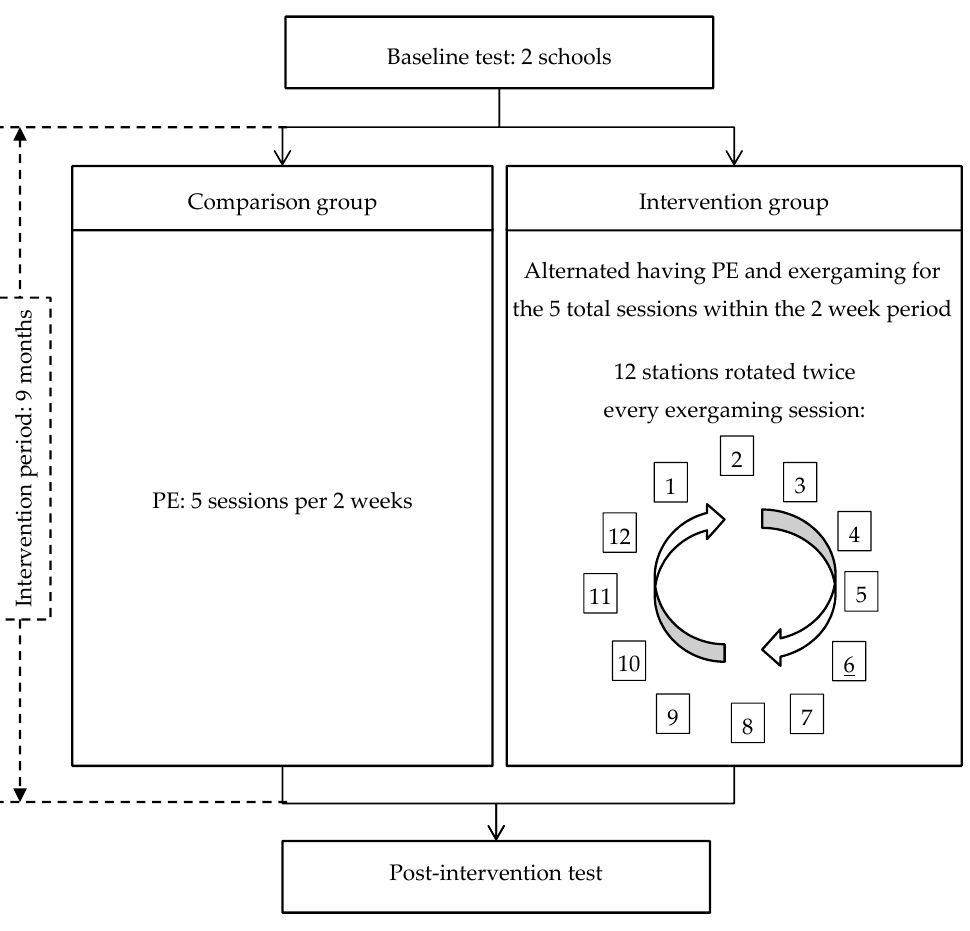
Figure 1. Study design and intervention flow.